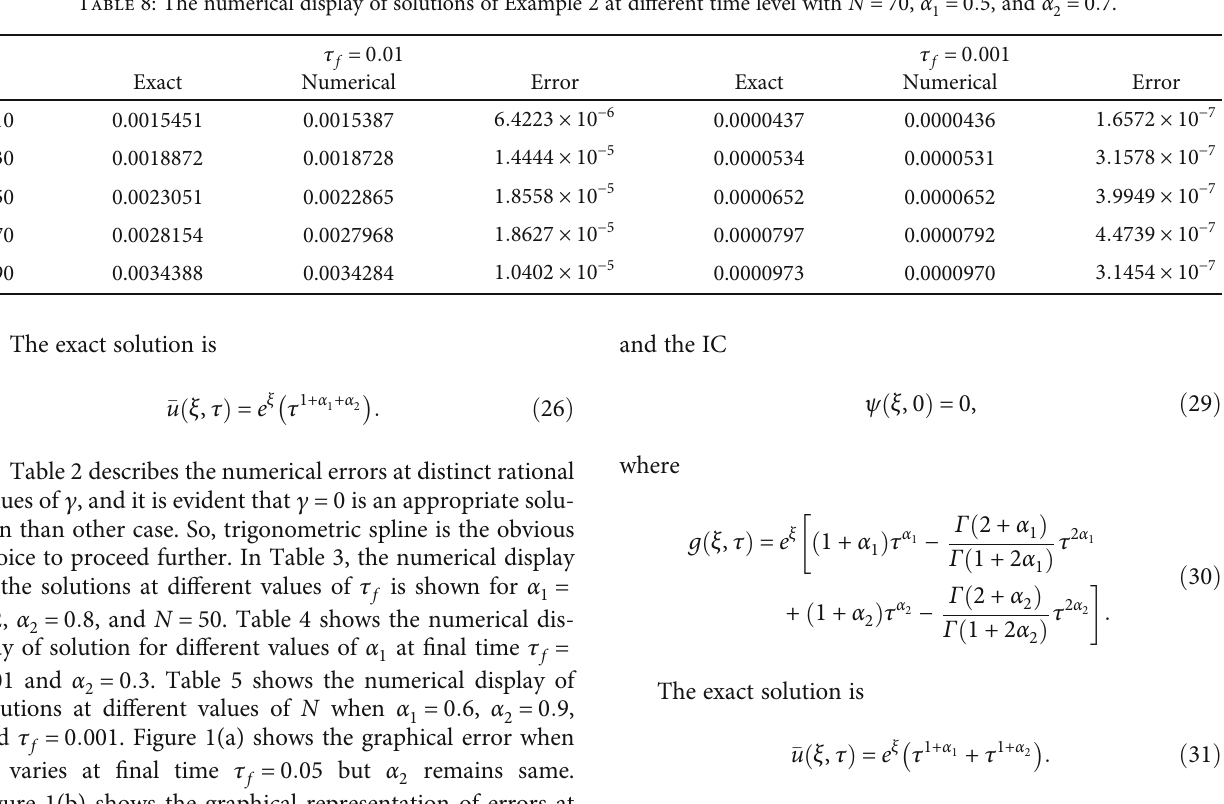
Table 7: The numerical display of the solutions at di ff erent values of α with N = 40 and τ